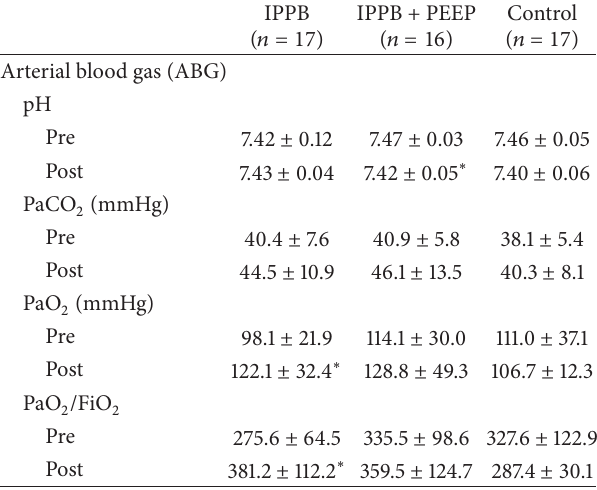
Table 3: Comparison of arterial blood gas data between groups.